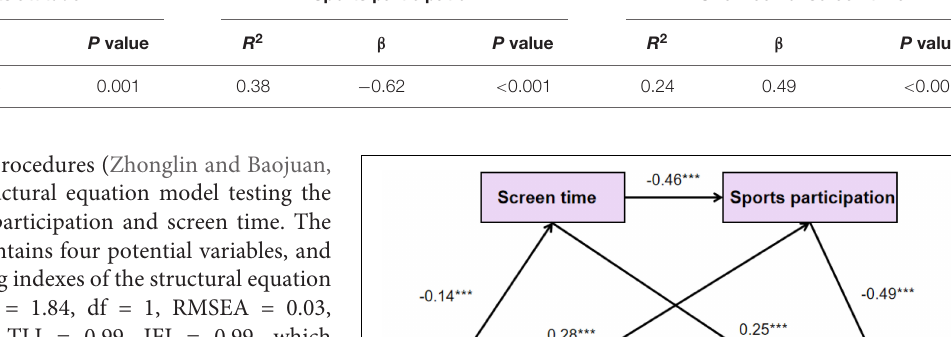
TABLE 4 | Linear regression of family sports attitude, sports participation, screen static time, and children’s BMI. Family sports attitude